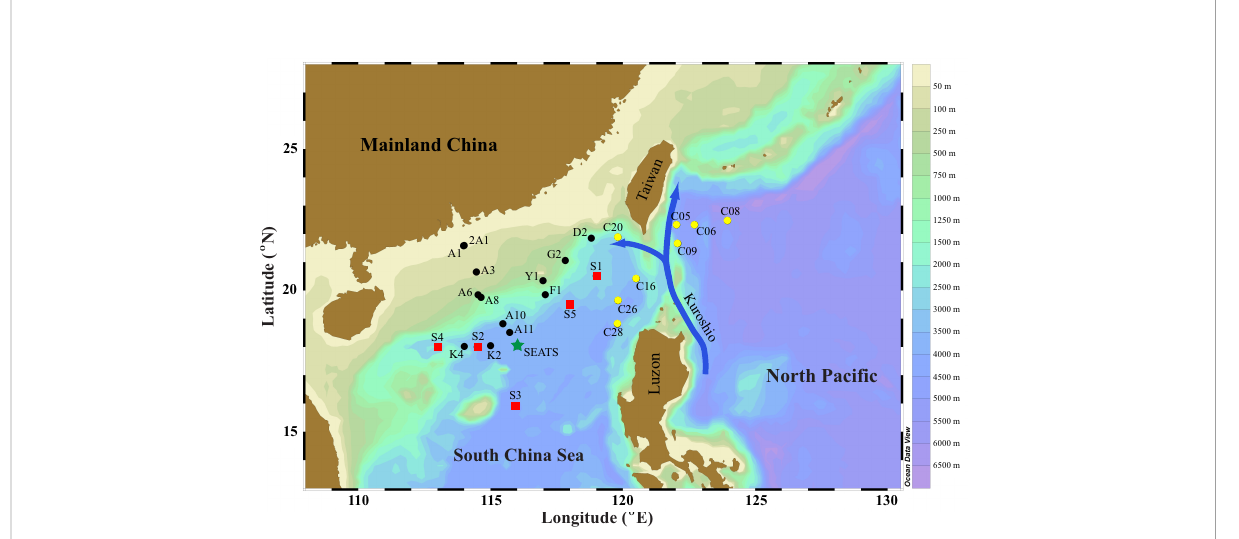
FIGURE 1 Map showing the study region and the locations of sampling stations in the northern SCS and western NP during three cruises in 2015 (red squares), 2016 (black circles) and 2019 (yellow circles), as described in the text. Seawater samples used for the incubation bioassay experiments were collected at the SEATS site (green star) during the cruise in May-June 2016. The blue arrows are the Kuroshio Current and its branching path into the SCS. Sampling stations in the SCS and western NP, from which published data were used for data validation in this paper, are also shown: S1, S2 and S3 (red squares) from the same cruise in 2015; D2, A11 and K2 (black circles) from the same cruise in 2016; and C05 and C08 (yellow circles) from the same cruise in 2019 (Ding et al., 2020). This map was created with Ocean Data View (ODV) (Schlitzer,